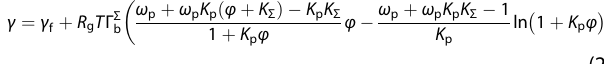
Comparison of model with experimental data